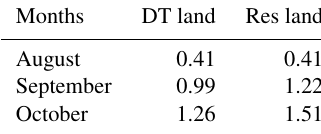
Table 2. Domain-averaged ( − 10 to 10 ◦ N and 95 to 125 ◦ E) monthly mean MODIS-derived AOD at 0.55µm over land for the operational (DT) and research (Res) algorithms. Months DT land Res land